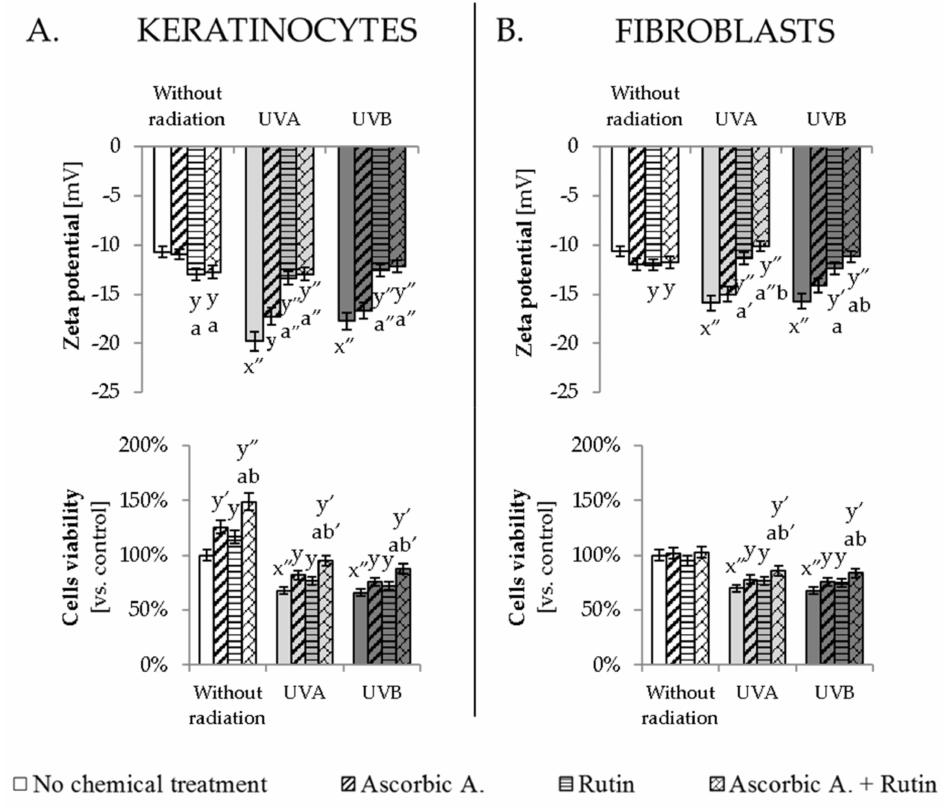
Figure 6. The changes in the Zeta potential and cells viability of keratinocytes ( A ) and fibroblasts ( B ) exposed to UVA (30 J/cm 2 and 20 J/cm 2 , respectively) and UVB irradiation (60 mJ/cm 2 and 200 mJ/cm 2 , respectively) and treated with ascorbic acid (Asc., 100 µ M) and rutin (Rut., 25 µ M). Mean values ± SD of three independent experiments are presented. x significant differences vs. non-treated group, respectively (x” for p < 0.0005); y significant differences vs. group without chemical treatment, respectively (y for p < 0.05; y (cid:48) for p < 0.005, y” for p < 0.0005); a significant differences vs. ascorbic acid-treated group, respectively (a for p < 0.05; a (cid:48) for p < 0.005, a” for p < 0.0005); b significant differences vs. rutin-treated group, respectively (b for p < 0.05; b (cid:48) for p <